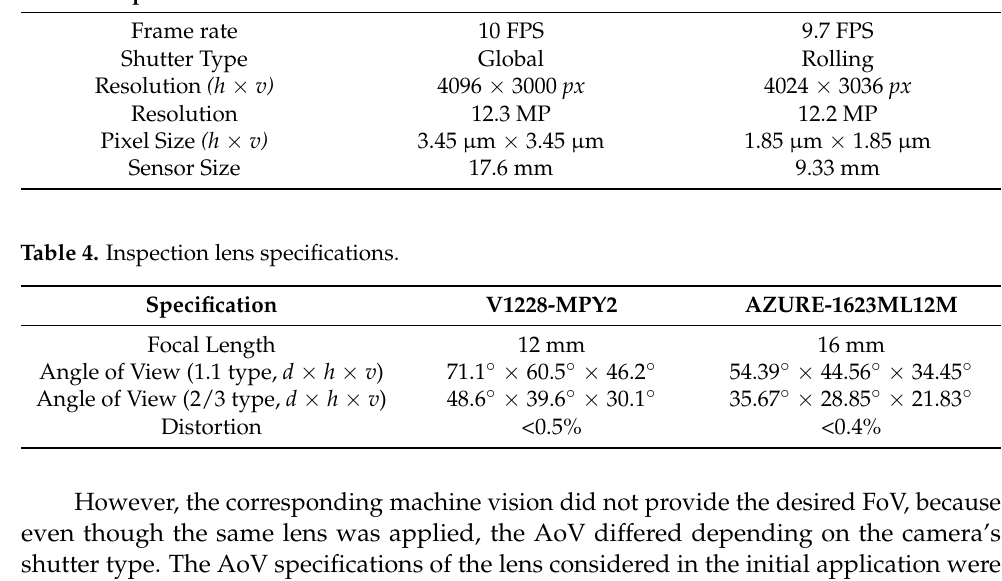
Table 4. Inspection lens specifications.